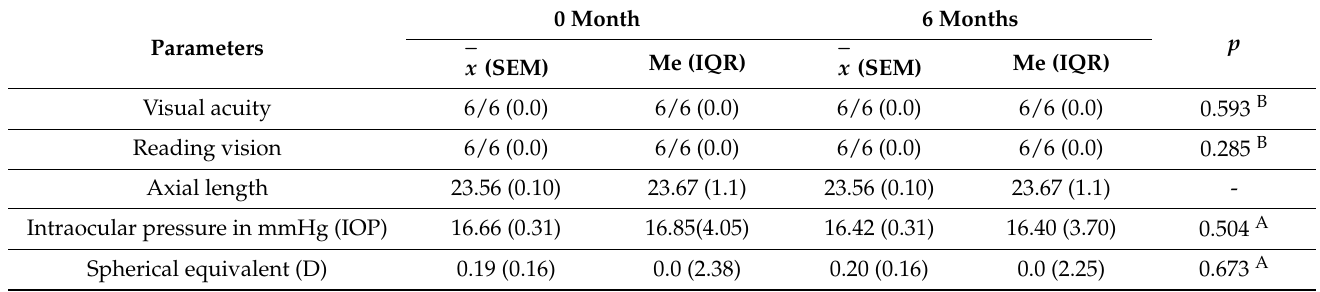
Table 1. Ocular characteristics of COVID-19 patients at 0 months and 6